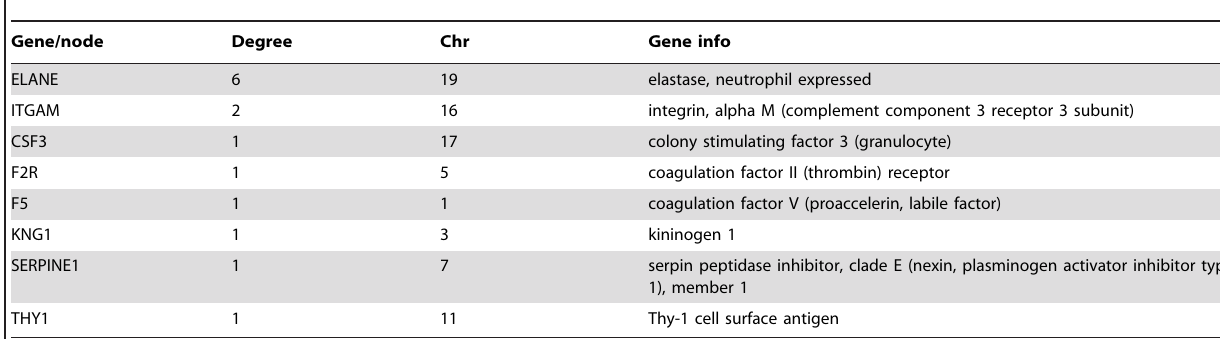
Gene/node details for the wound healing module found as significant in the KIRC data set.